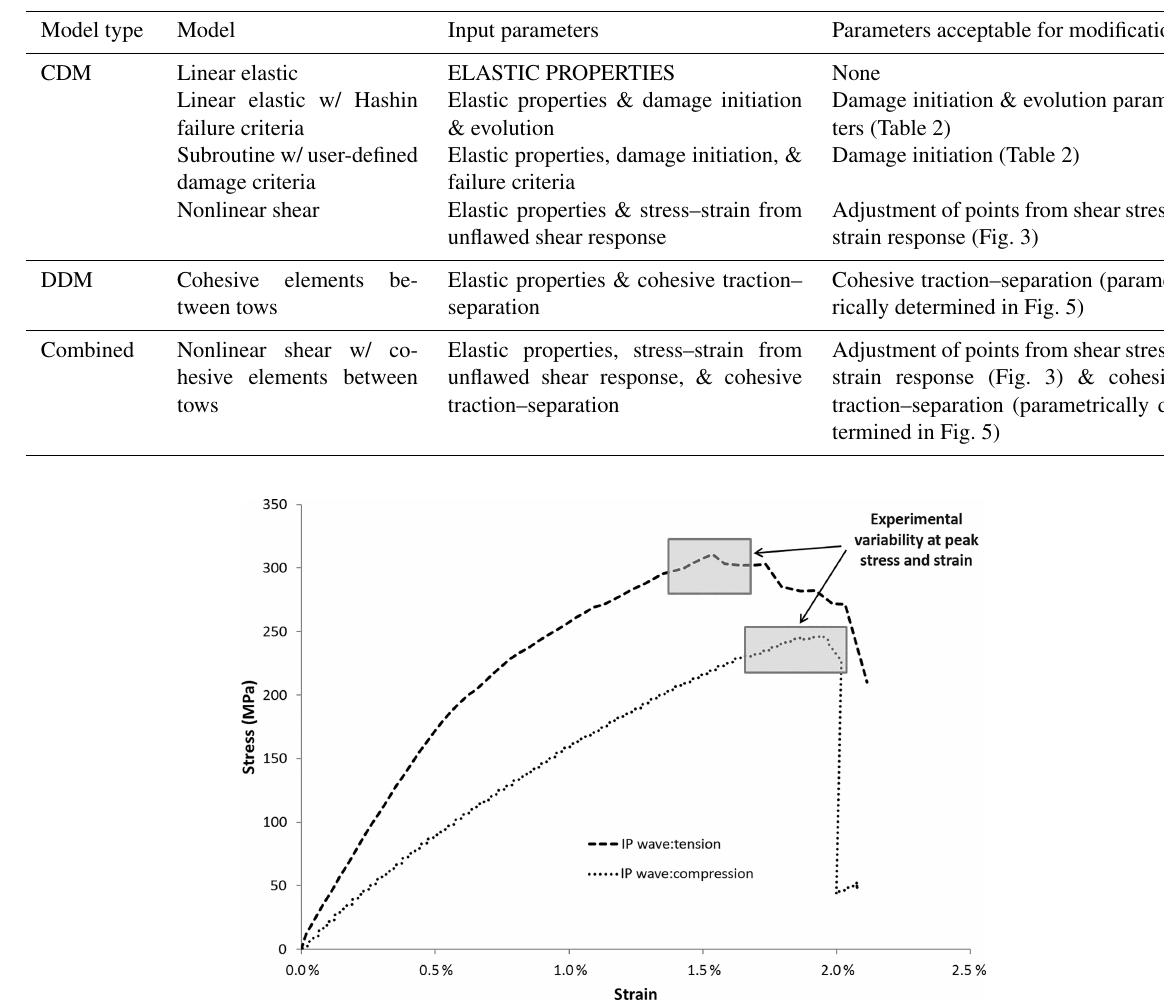
Figure 7. Tension and compression response of IP wave 1 utilized for baseline correlations with associated experimental